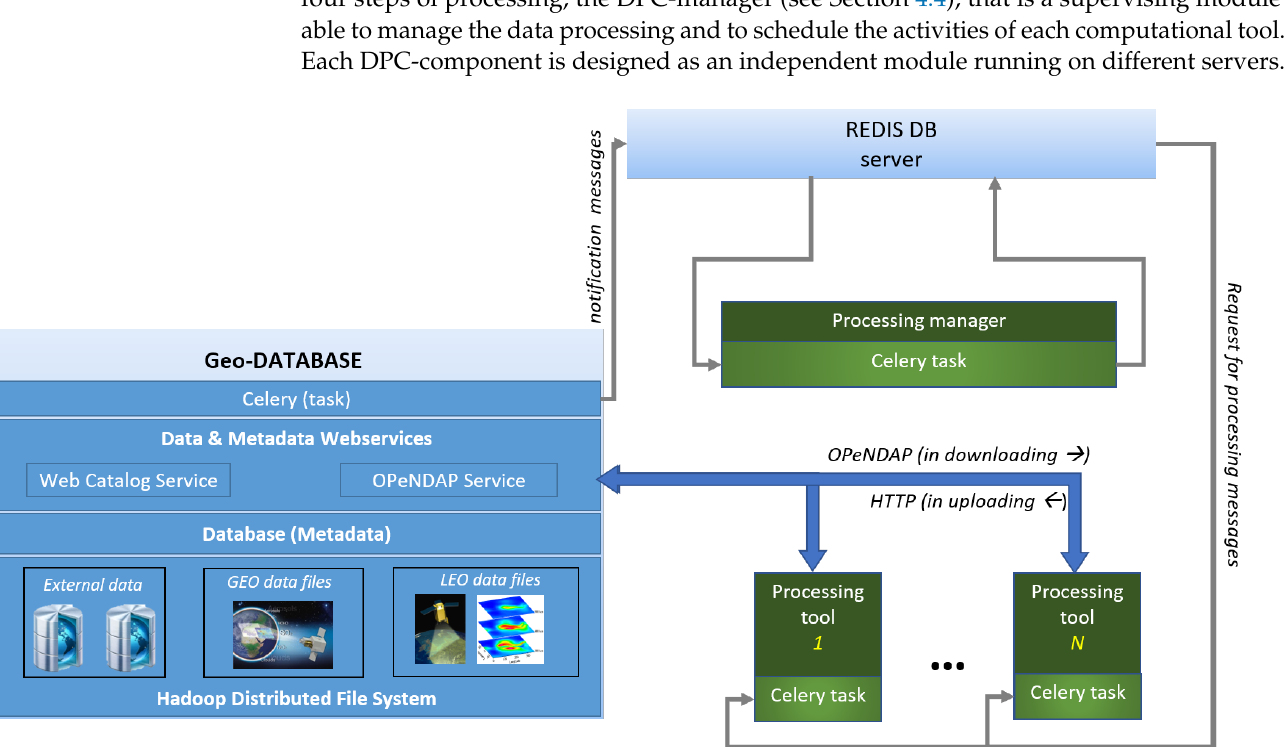
Figure 3. Schema of the architecture of the technological